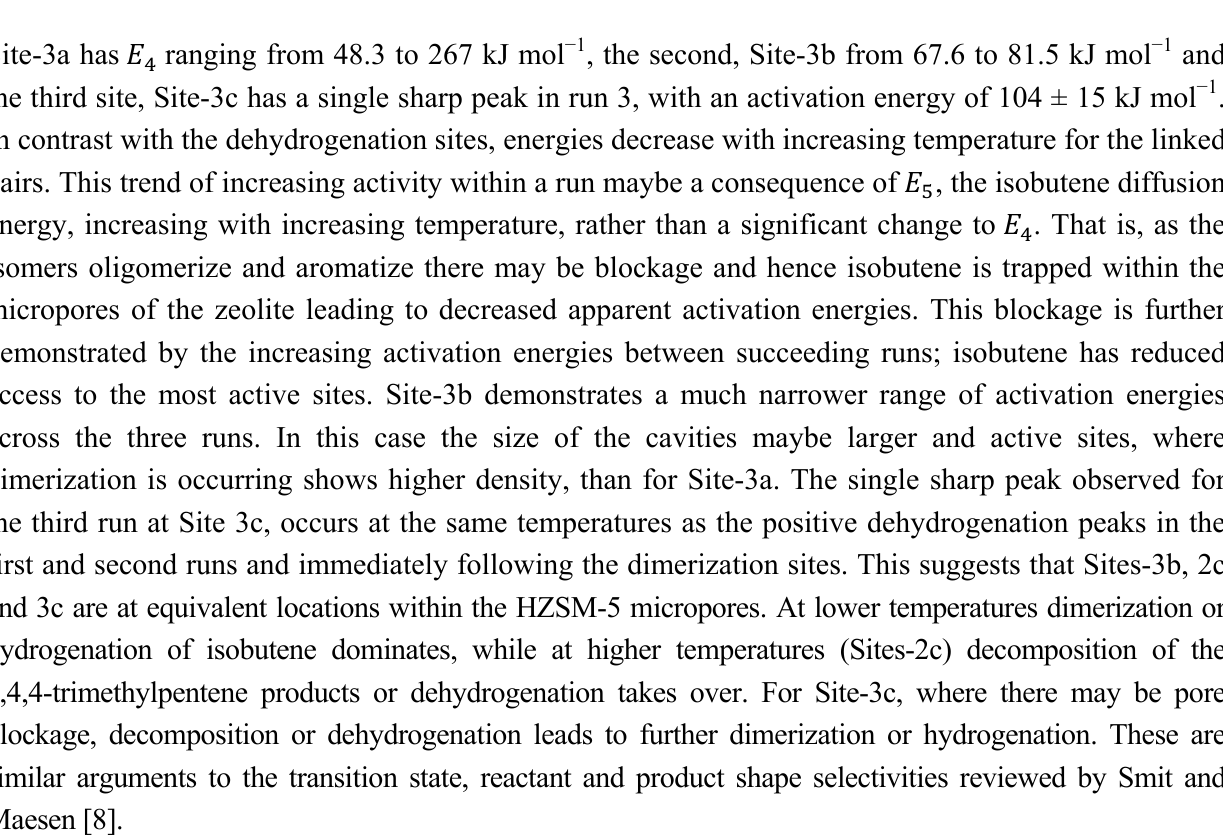
) and collision frequencies (cid:2872) (cid:3404) 0 , and the ratio log (cid:1827) : (cid:1827) (cid:3406) (cid:2869) (cid:2869)(cid:2868) (cid:2873) (cid:2872)